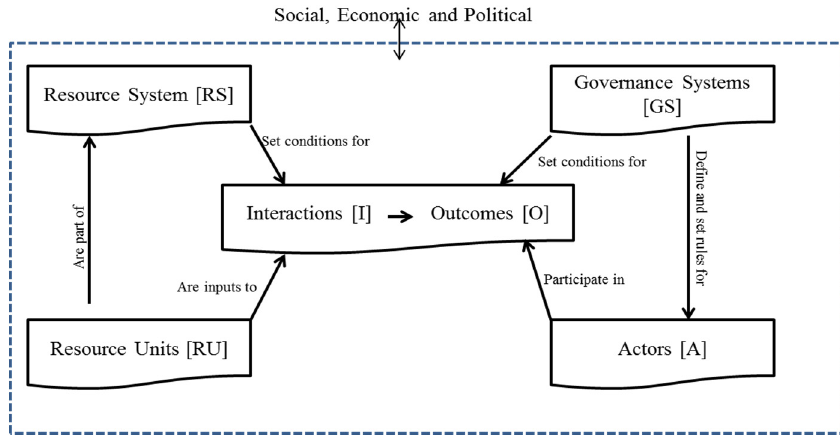
Figure 1. The SES framework [24].